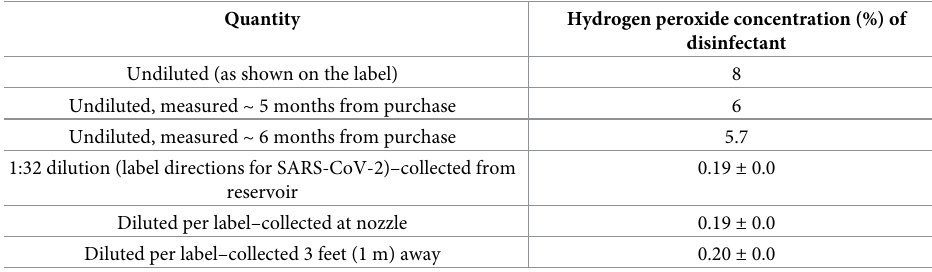
Table 5. Fate of active ingredient when spraying hydrogen peroxide-based disinfectant. Quantity Undiluted (as shown on the